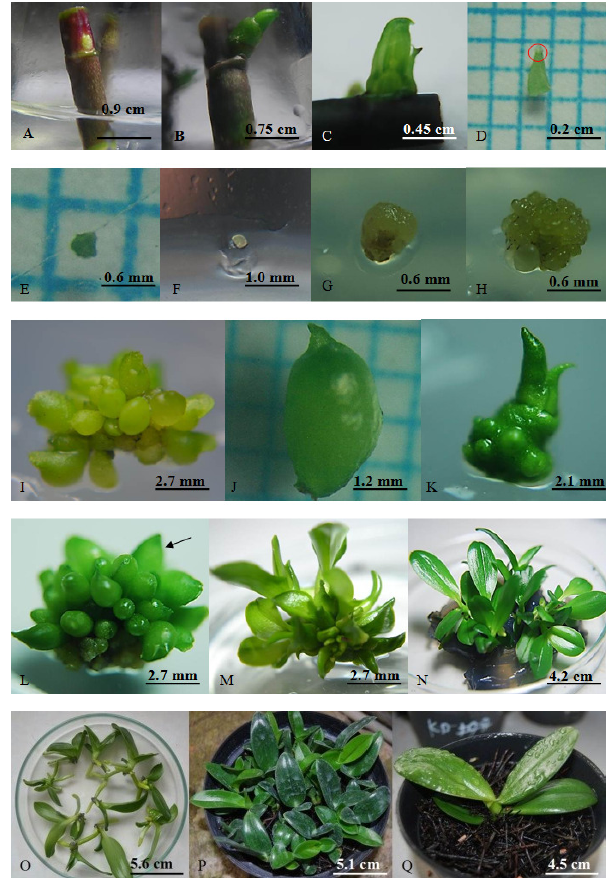
Fig. 4. Development of in vitro propagation protocol via shoot tip explant embryogenesis of Phalaenopsis selected-clones. A. Inflorescent node in the initial culture, selected to regenerate shoot as explant source; B. Regenerated- shoot 1.5 months after culture; C. Cross section longitudinally of shoot isolated as explant source; D. Initial isolated-shoot tip prepared and used as explant source; red circle indicate area where the shoot tip explant isolated; E. Size of shoot tip (± 3 × 3 × 3 mm; length, width and height) used for explant source; F. Initial condition of shoot tip cultured on initiation medium; G. Initial embryogenic callus derived from shoot tip on half-strength Murashige and Skoog (MS) medium with full strength micro, Fe-chellate and vitamin containing 0.5 mg/L thidiazuruon (TDZ) and 0.25 mg/L M6- benzyladenine (BA) ± 15 days after culture; H. Development of initial embryos 1.5 months after culture; I. Mature embryos derived from shoot tip ± 3 months after culture; J. Single embryo used as explant source in proliferation and multiplication step; K. Single embryo with initial secondary embryos on half-strength MS medium supplemented with 0.13 mg/L TDZ and 0.25 mg/L BA 1.5 months after culture; L. Mature embryos derived from single embryo culture on the selected proliferation medium ± 3 months after culture; Black arrow indicates the originated embryo; M. Germinated embryos on half-strength MS medium with full strength of vitamin and hormone free ± 2 months after culture; N. Plantlets prepared for acclimatization on half strength MS medium with full strength of vitamin, 2 g/L AC and hormone free ± 2 months after culture; O. Plantlet performance prepared for acclimatization; P. Well growth performance of acclimatized plantlets on C. rumphii bulk 3 months after acclimatization; Q. Performance of individual acclimatized-plant ± 4 months after repotting on the same